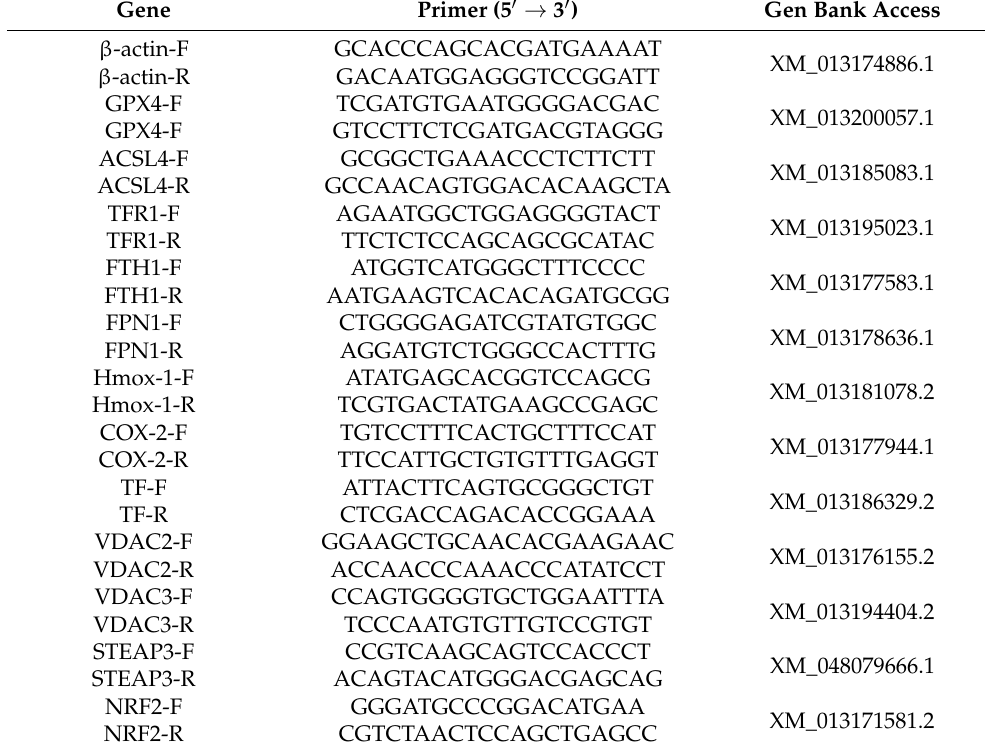
Table 1. Primer sequences for qPCR.